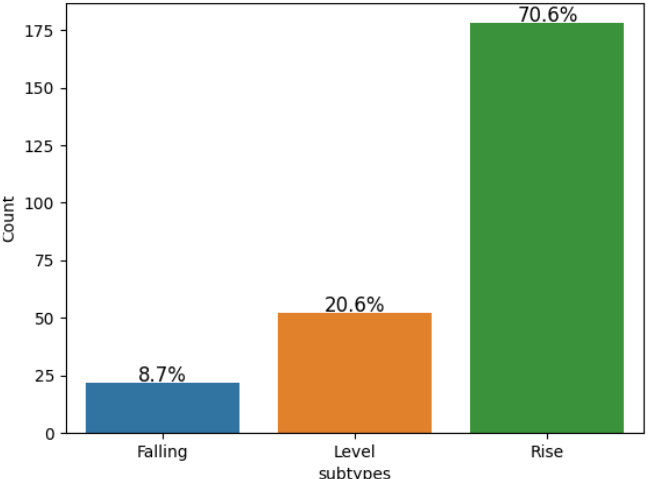
Figure 5. The distribution of contour types over ¿no?